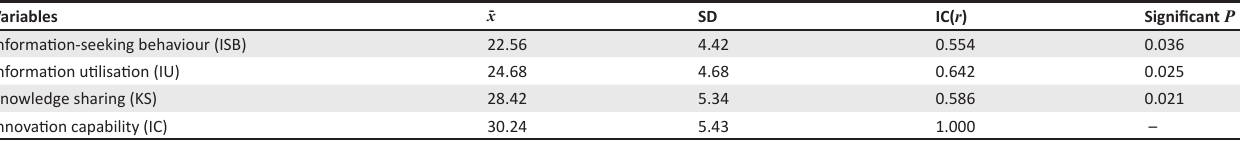
TABLE 5: Summary of test of significant relationship amongst information-seeking behaviour, information utilisation, knowledge sharing and innovation capability of the